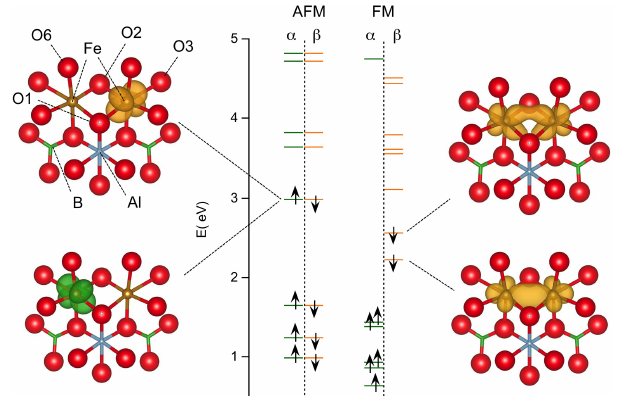
Figure 5. Energy levels of iron pairs in tourmaline calculated with the PBE functional (models 1 and 3, Table 2). The energy is reported with respect to that of the top of the valence band (O(2p) states) in the theoretical model of pristine dravite. The majority ( α ) and minority ( β ) spin states correspond to the green and orange bars, respectively. Isosurfaces corresponding to the spin-selected density of states of the two highest occupied spin orbitals are reported. Fe– Fe interaction in the FM configuration is attested by the electron delocalization over the two Fe atoms. In the AFM configuration, the electrons with opposite spin states are localized on each Fe